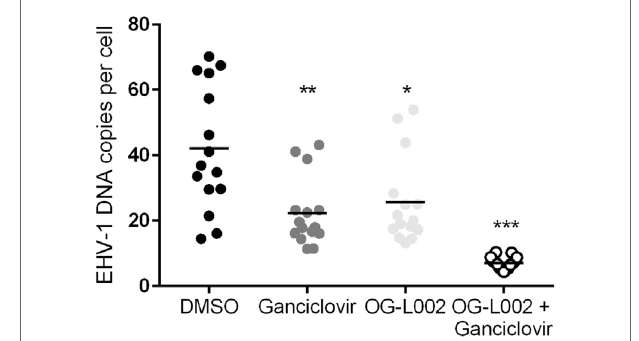
FigUre 2 | Effect of treatment on equine herpesvirus type 1 (EHV-1) viral load during lytic infection of primary equine fetal kidney cells. At 24 hpi, reduced EHV-1 DNA copies per cell were detected in the presence of ganciclovir (** p = 0.0005) or OG-L002 (* p = 0.005), and markedly when both treatments (*** p < 0.0001) were applied simultaneously in comparison with DMSO control vehicle. Combined treatment decreased the number of EHV-1 DNA copies in comparison to treatment with ganciclovir alone ( p = 0.01) or OG-L002 alone ( p = 0.001). Lines represent mean values.